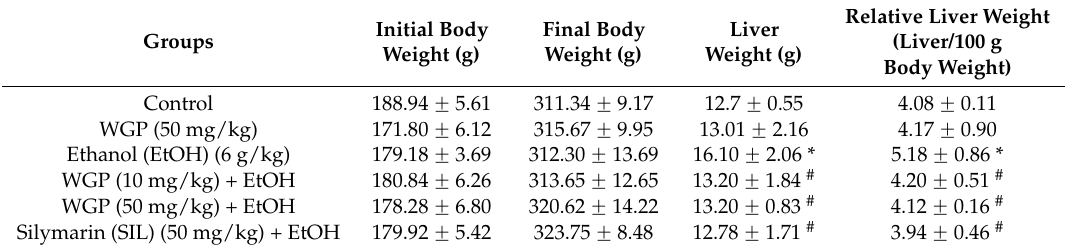
Table 1. Effect of wild grape seed procyanidins (WGP) on body weight and liver weight/body weight in ethanol-treated Sprague-Dawley (SD)-rats. Each value represents the mean ± SD for five rats. Groups